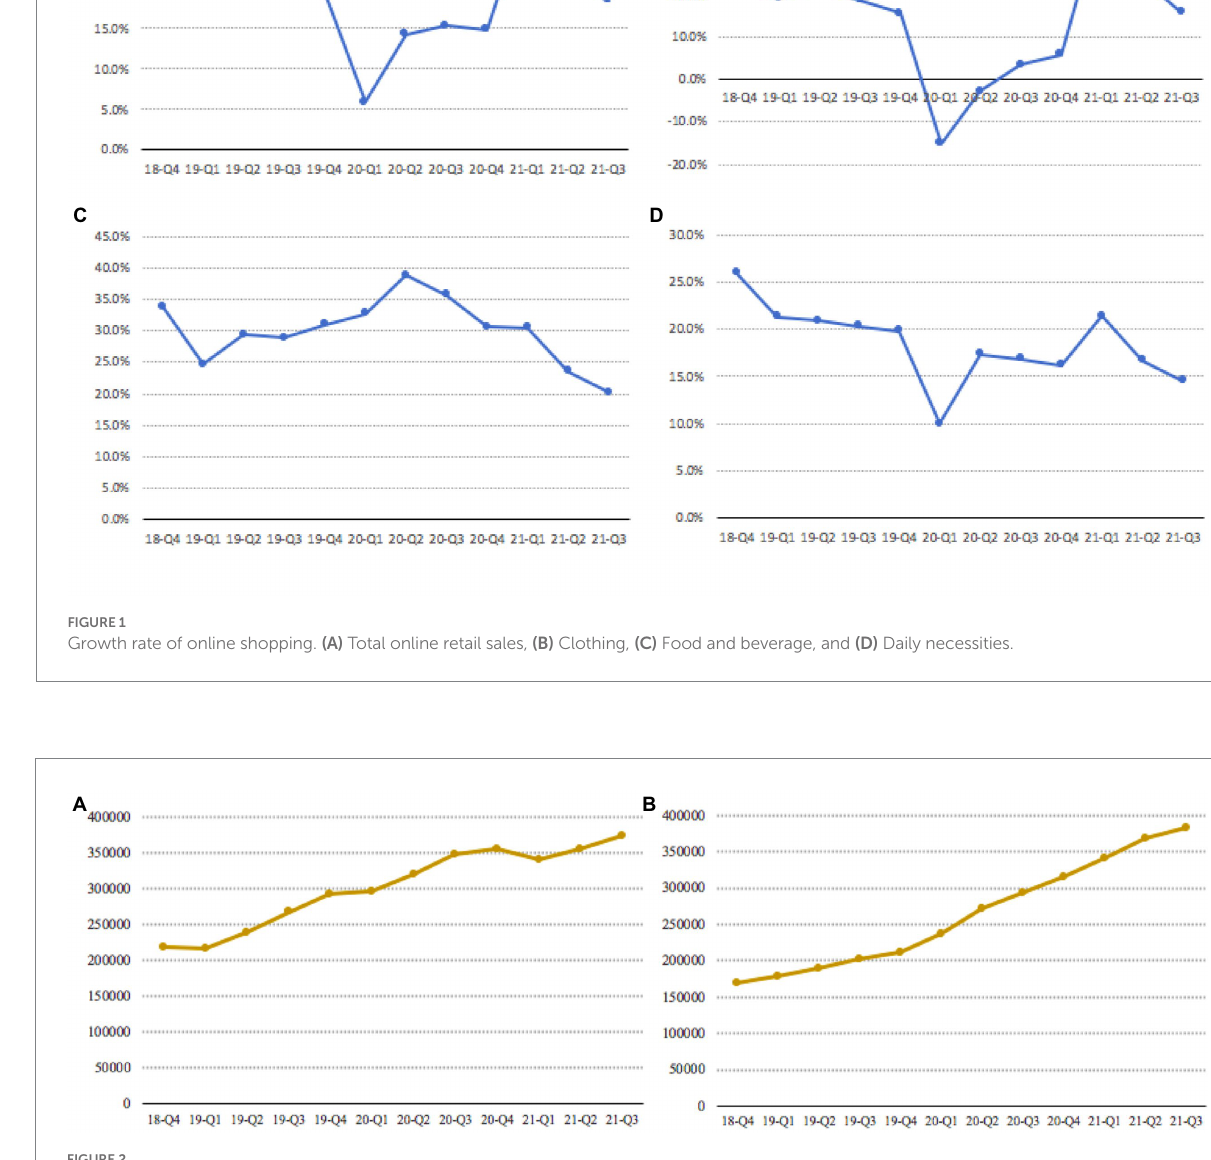
FIGURE 2 Growth in the number of agents on e-commerce platforms (A) Tmall and (B) JD.